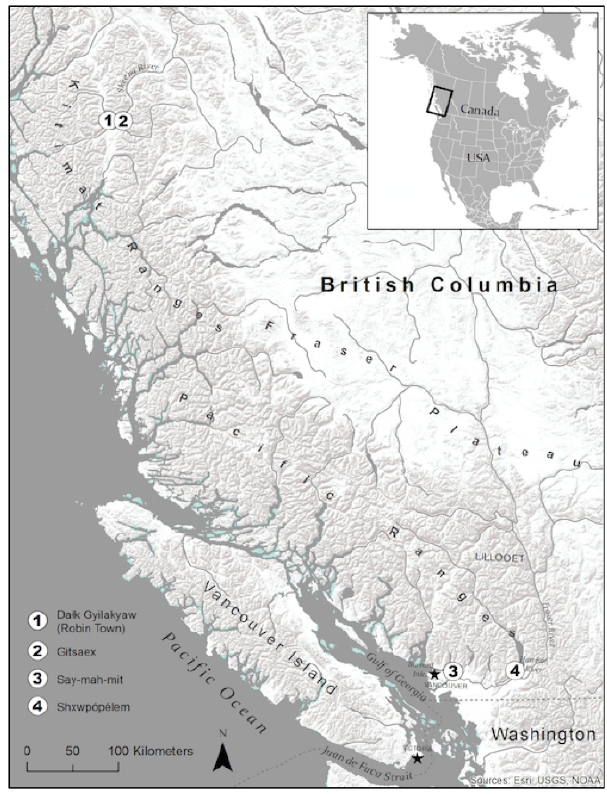
Fig. 2 . Location of Study Sites. Archaeological